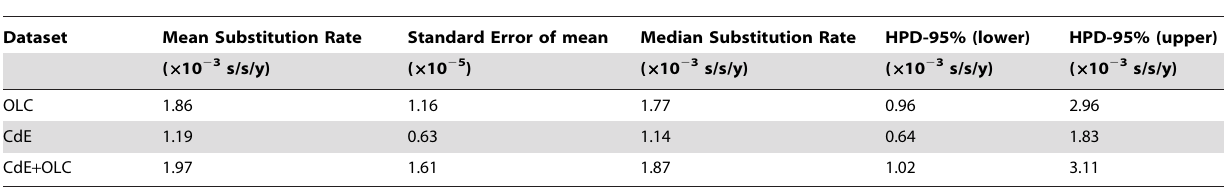
Table 5. Summary for E2 substitution rate estimations.